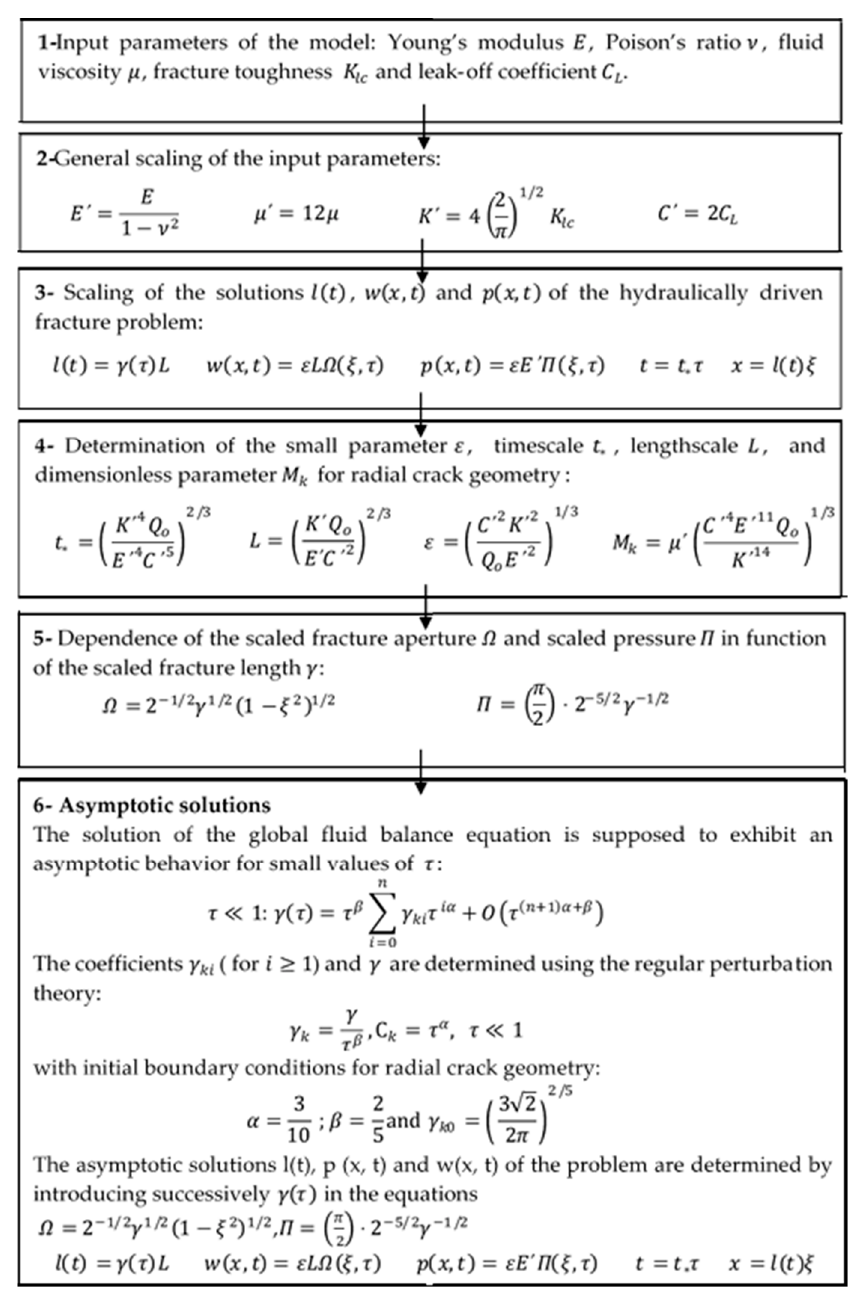
Figure 3. Flowchart algorithm for the determination of asymptotic solutions.